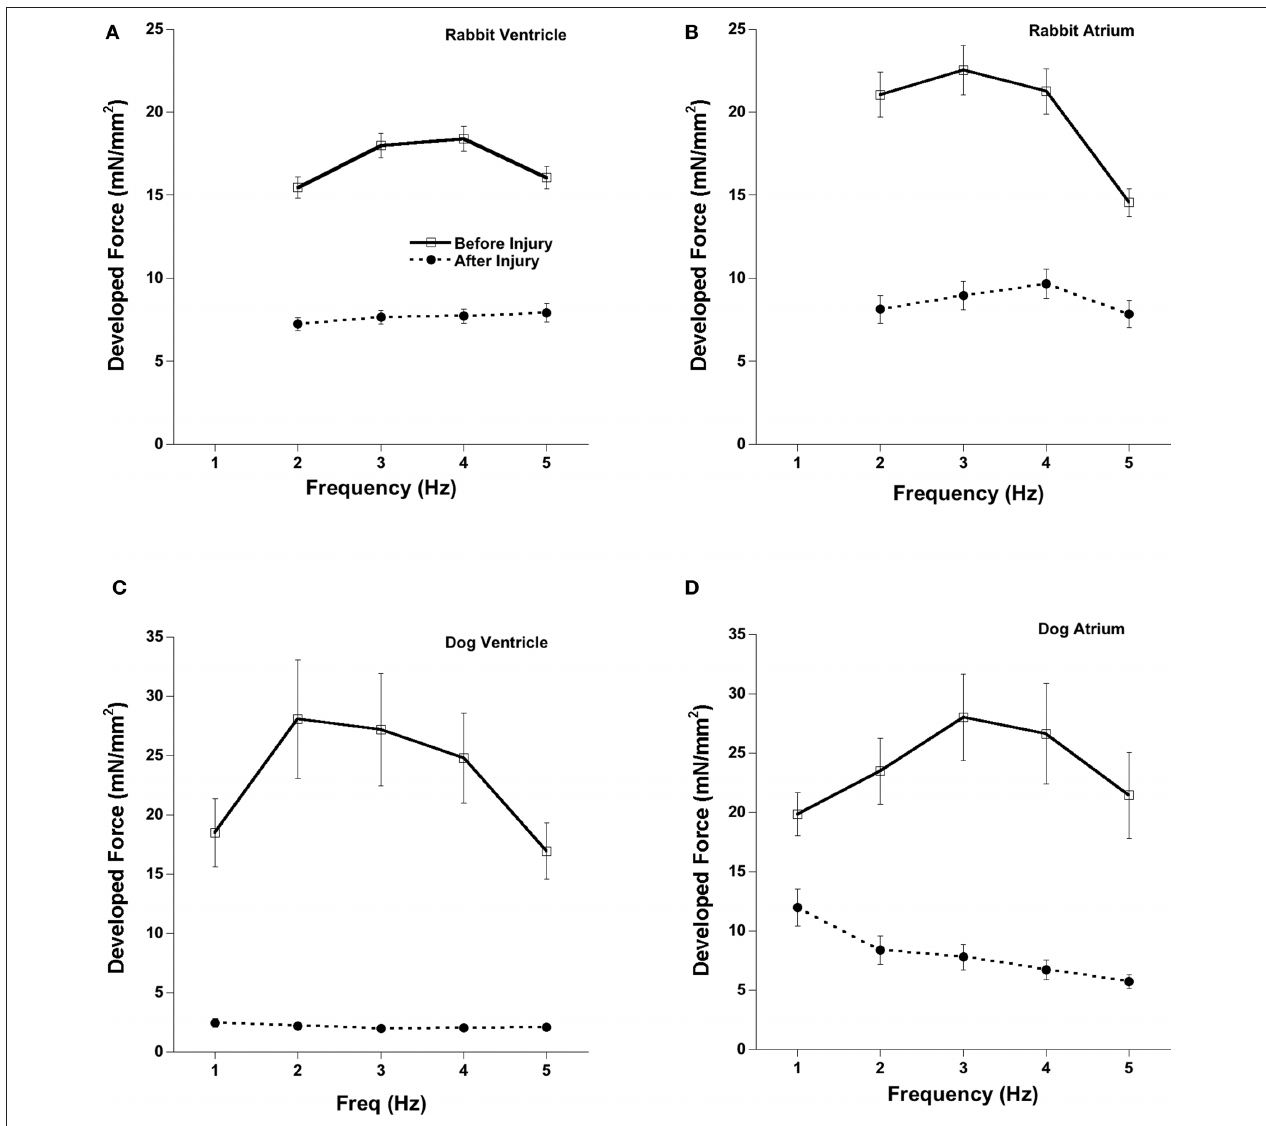
FiguRe 5 | Force-Frequency relationships before and after 2 min of OH-radical exposure on cardiac trabeculae. About 45–60 min after OH-exposure, the flat force-frequency relationship was much less pronounced